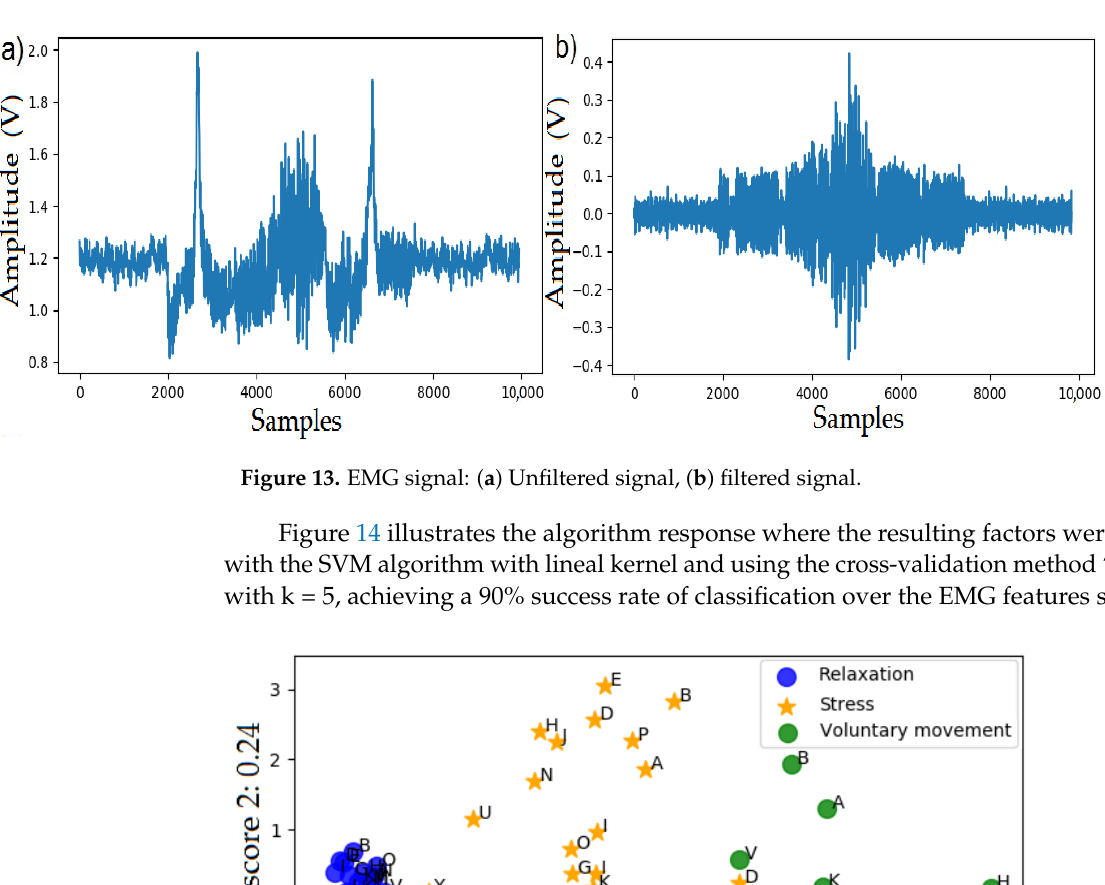
Figure 13. EMG signal: ( a ) Unfiltered signal, ( b ) filtered signal.